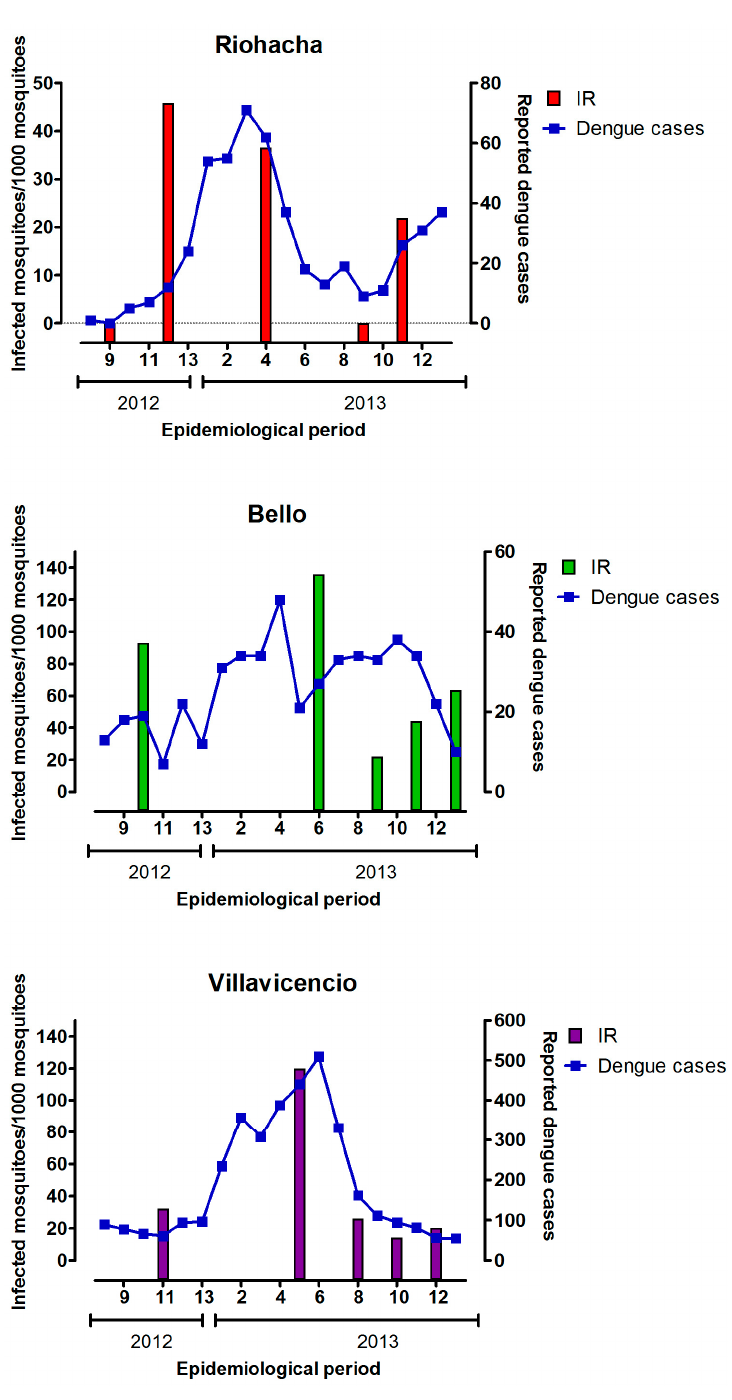
Figure 3. Behavior of dengue cases notified by INS (blue line) and IR of mosquitoes (bars) through the time of study (mid-2012 and 2013). Epidemiological period and year are displayed in the x-axis.